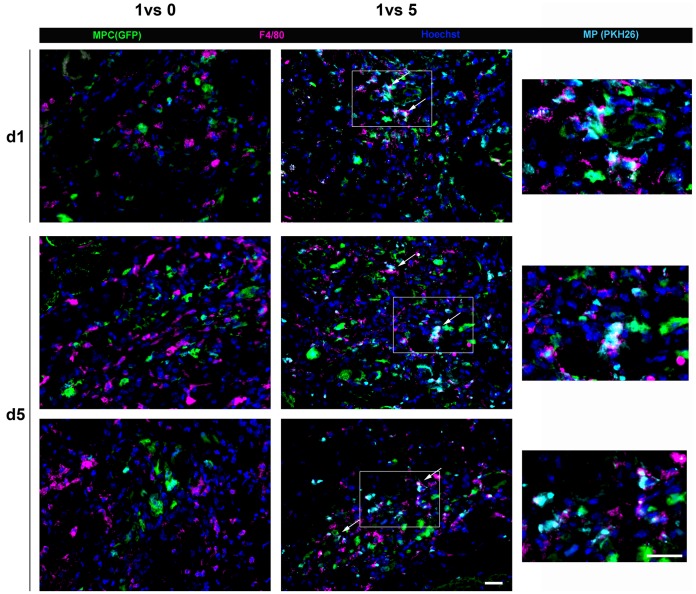
Localisation of MPCs and MPs at sites of transplantation.GFP-MPCs were injected with or without MPs which were labelled with PKH26 before the cotransplantation into mdx muscle. Immunolabellings of the pan-macrophage marker F4/80 (magenta) were performed on sections at day 1 and 5 after transplantation. Green = MPCs, cyan = PKH-labelled MPS, blue = Hoechst). Arrows show colocalization of cyan and magenta stainings (white) indicating the expression of F4/80 by transplanted MPs. Two examples from different muscles are given for day 5. Bar = 10 µm. Inserts on the right panel represent higher magnification of the fields delimited by rectangles. Bar = 20 µm.